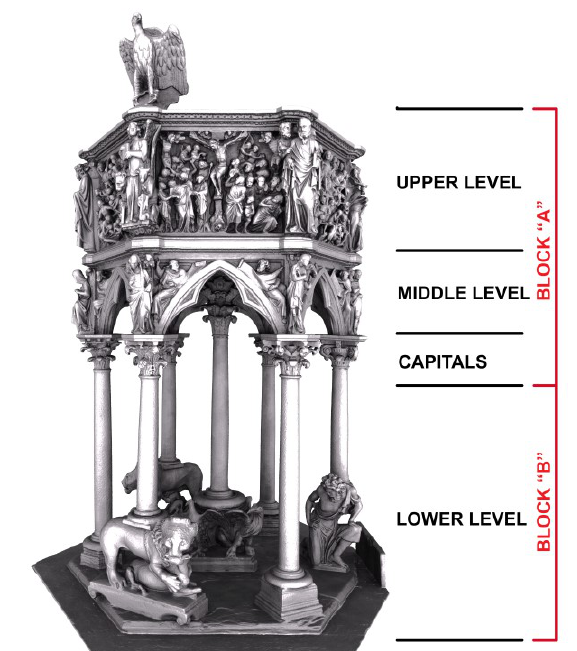
Figure 2. Subdivision of the work in blocks and levels (on the C10 mesh model).